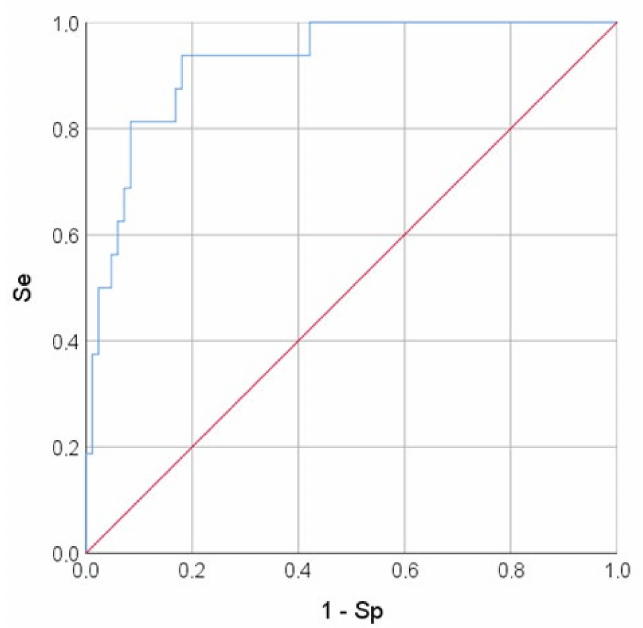
Figure 3. ROC-curve. The mortality risk on the values of the logistic function P%. The AUC- ROC was 0.925 ± 0.031 (95% CI: 0.863–0.986). The Se and Sp measures of model (1) at the cut-off point of 0.129 were 93.8% and 81.9%, respectively. The red line is the zero predictive value line (at Se + Sp = 100%), blue line–ROC-curve representing to the sensitivity function of the proportion of misclassified negative